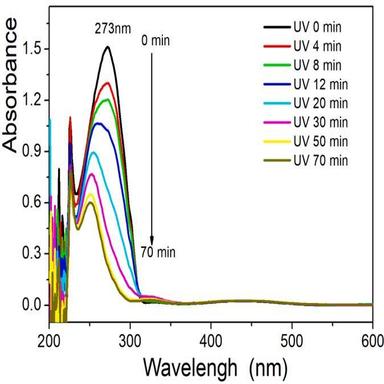
Time-dependent UV-visible absorption spectra of PEO-PFc-PCA solution under LED UV lamp illumination (310 nm, 12 W).